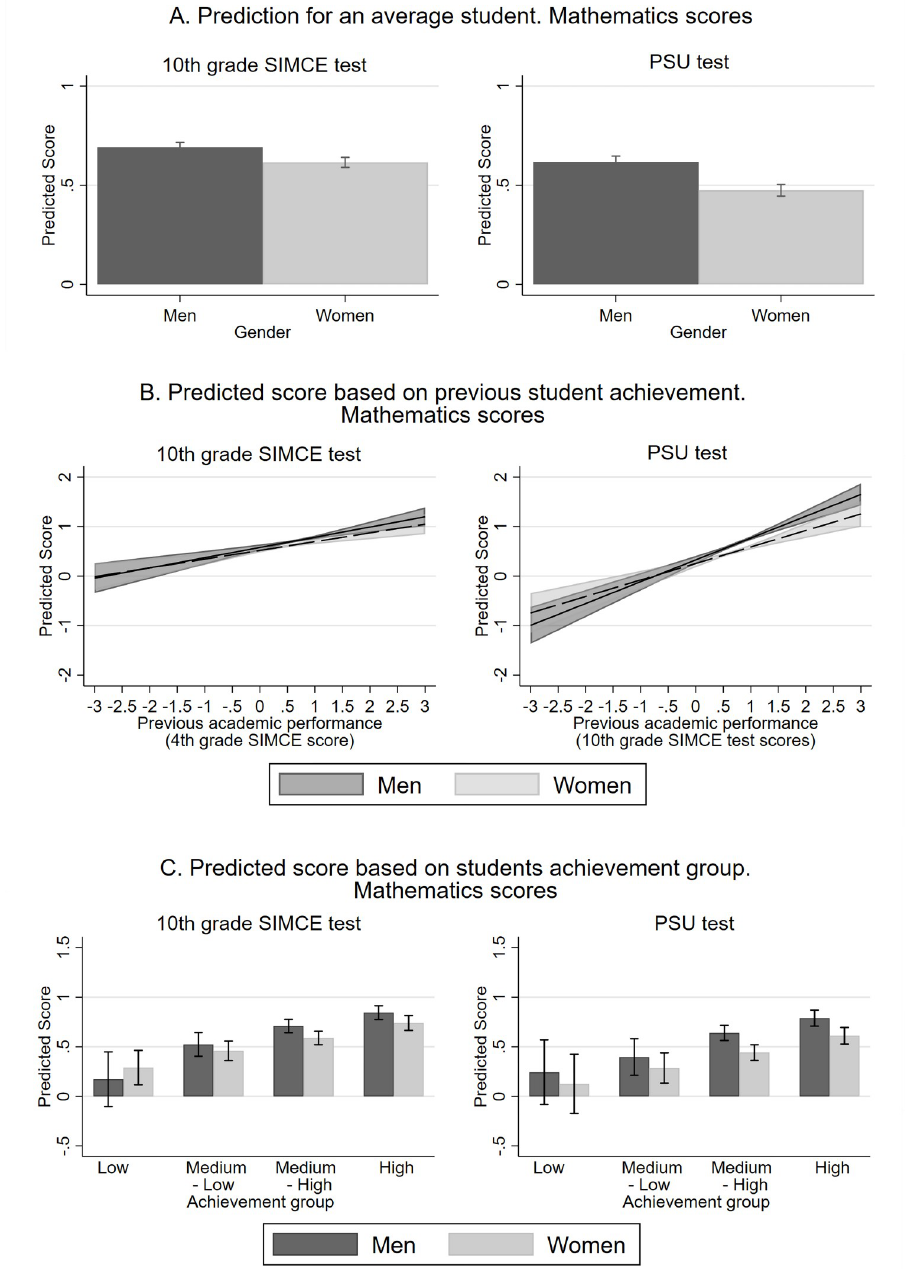
Fig 2. Predictions of Mathematics scores in competitive (PSU) and noncompetitive (10 th grade SIMCE) tests. The figure shows predictions for students with average characteristics but different gender (panel A), different previous Mathematics SIMCE test scores and gender (panel B), and different achievement groups and gender (panel C). All the predictions show 95% confidence intervals. The estimations of panels A, B, and C were made with models (1), (2), and (3), respectively. Table 4 shows the coefficients of those